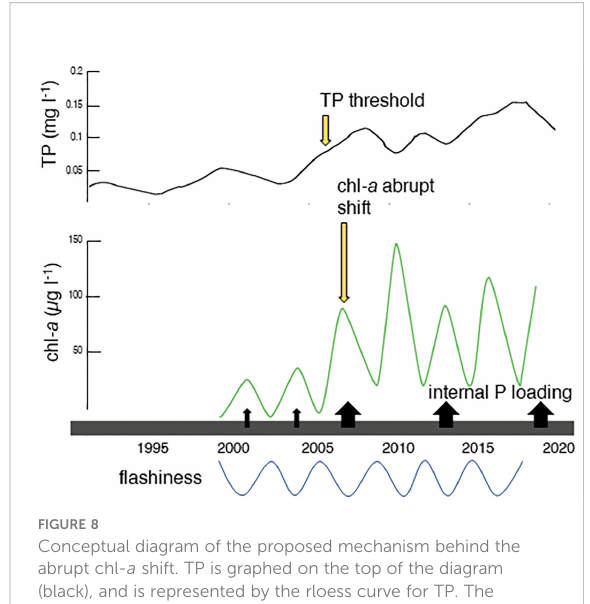
FIGURE 8 Conceptual diagram of the proposed mechanism behind the abrupt chl- a shift. TP is graphed on the top of the diagram (black), and is represented by the rloess curve for TP. The remainder of the variables are stylized, and do not represent true values. Chl- a (green) is graphed below TP and internal P loading is represented by black arrows. Flashiness is represented on the bottom of the graph (blue). Following the crossing of the TP threshold in 2005, sedimentary storage of P built to a level that resulted in higher internal P loading. This increased supply of phosphorus to the water column triggered the abrupt shift in 2006, when fl ashiness was low. Low fl ashiness translated to less fl ushing events and higher retention times, allowing the system to utilize the higher water column P released by internal